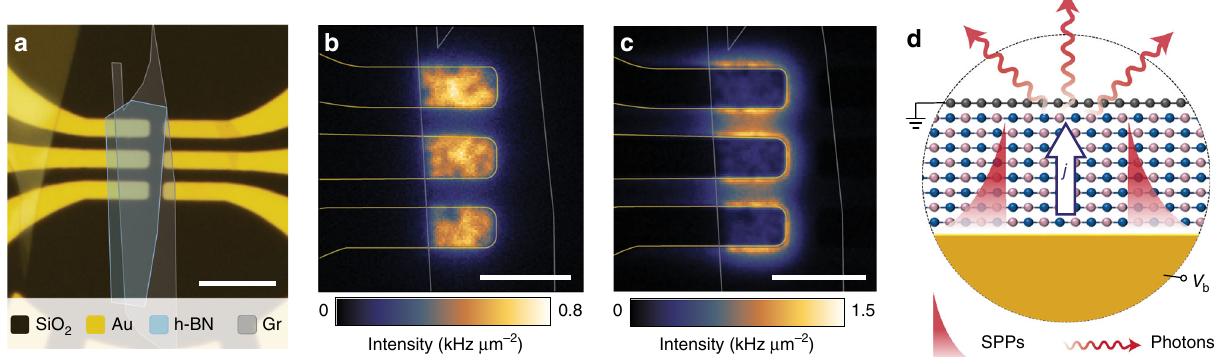
Fig. 2 Light emission from vdWQT devices. a Optical microscope image of a set of devices. The three areas on the left, where gold electrodes (50 nm), h-BN crystal ( N = 7) and graphene overlap, form the tunneling devices. Electrodes on the right serve as electrical contacts to the graphene sheet. Scale bar: 10 μ m. b Spatial distribution of photons emitted into the air/upper half-space above the graphene sheet from the devices at an applied voltage of 2.0 V. Light is emitted from the entire area of the devices. Scale bar: 5 μ m. c Corresponding distribution of photons emitted into to substrate/lower half-space. Light is observed primarily at the edges of the devices. Scale bar: 5 μ m. Straight lines in b , c mark the outlines of gold electrodes (gold) and graphene (gray). Intensity units are as measured and not corrected for system ef fi ciency. d Sketch of the vertical cross-section through the device, illustrating the mechanism of light generation. The inelastic component of the tunneling current j couples to the optical modes of the vdWQT device, i.e., the free-space continuum of optical states as well as surface-bound SPP modes (not to scale). Photons emitted into the air half-space give rise to the image in b , SPP scattering at the edges of the gold electrodes generate the image in c